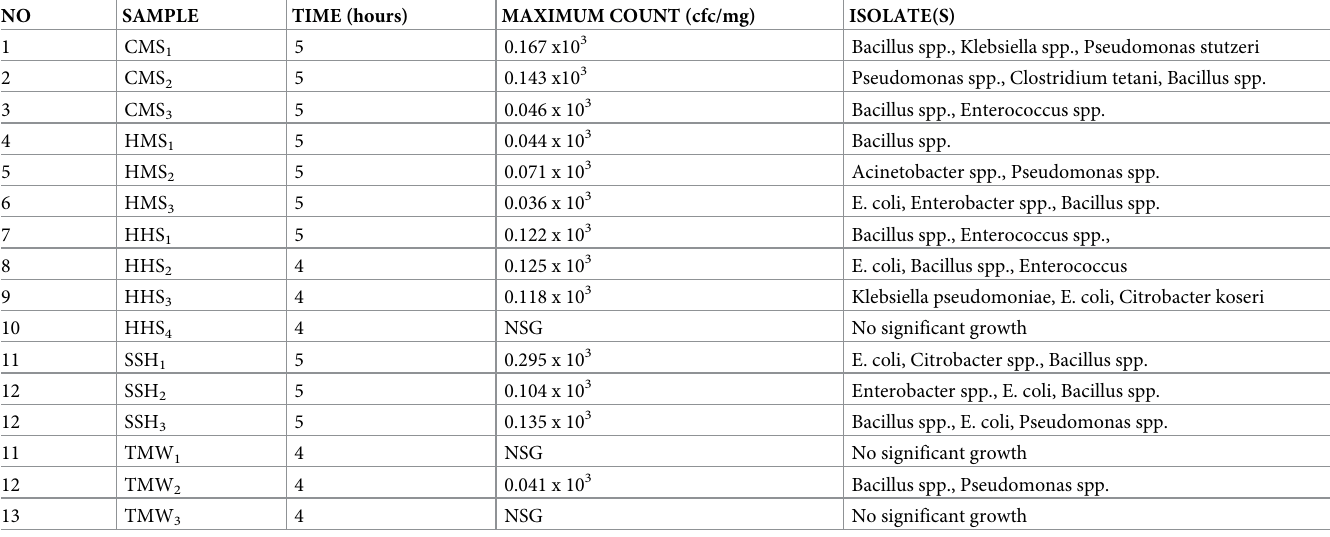
Table 4. Bacteria detected in solid medical waste and soil from medical waste dump sites.